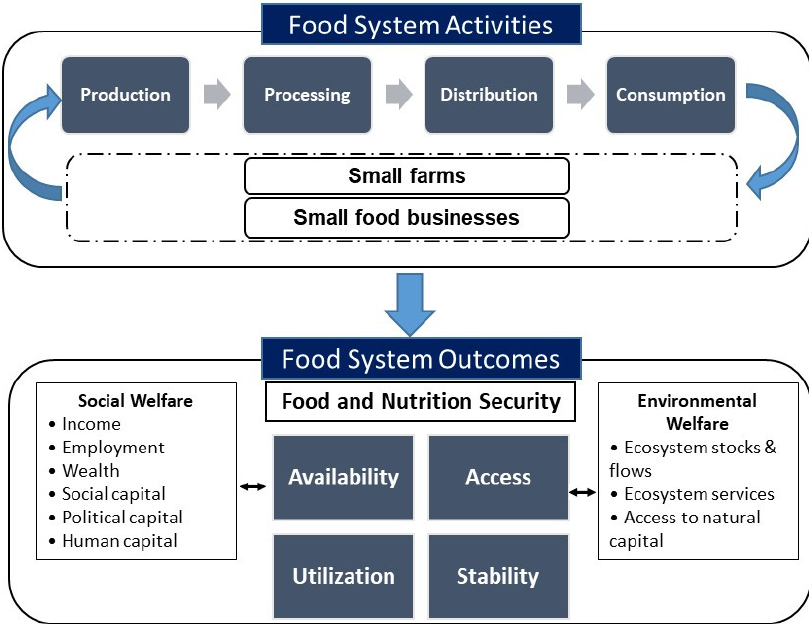
Figure 2. Food system representation (adapted from [51]).